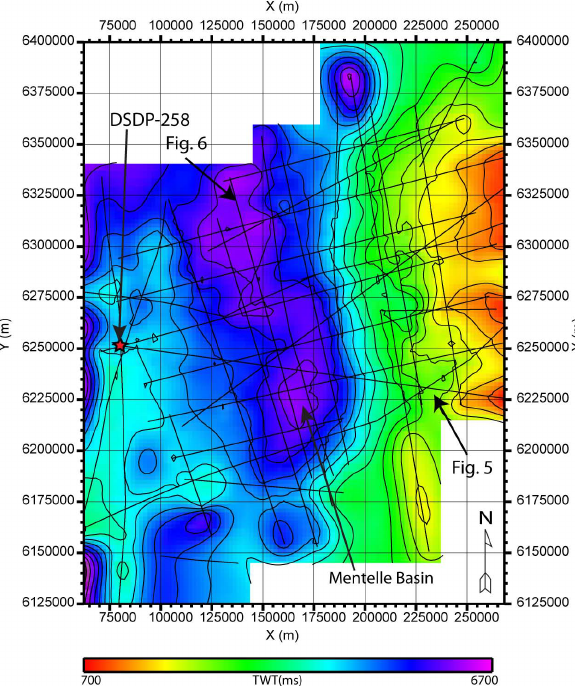
Fig. 11. TWT map of the Valanginian-Late Hauterivian breakup unconformity. This extensive unconformity can be mapped across the entire basin and marks a change from volcanic associated rifting to thermal subsidence and eventual deposition of black